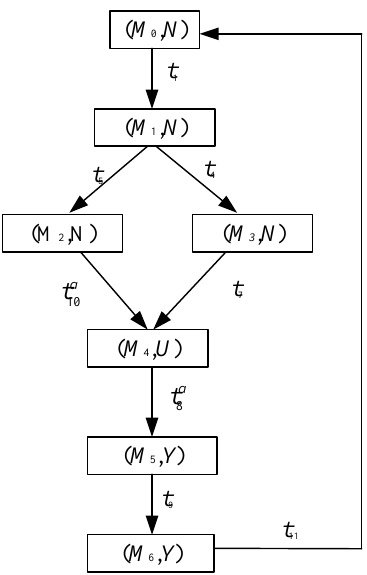
Figure 10. Label basis attack model G ξ